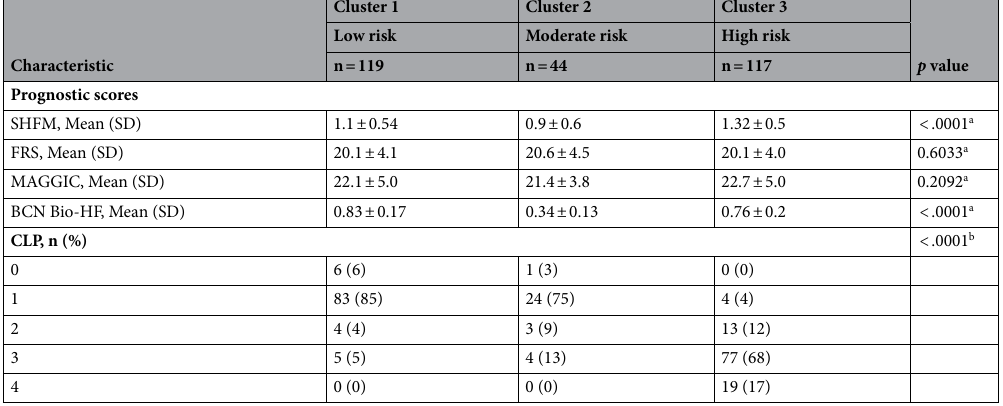
Table 3. Comparison of cohort characteristics and prognostic scores. Cohort characteristics and prognostic score distribution across risk clusters. The prognostic scores used for clustering were: SHFM (Seattle Heart Failure Model), FRS (Framingham Risk Score), and MAGGIC (Meta-analysis Global Group in Chronic Heart Failure), BCN Bio-HF (Barcelona Bio-Heart Failure Risk Calculator), and Cardiac Lipid Panel Risk Score (CLP). Each prognostic score was standardized to the same scale (mean = 0; SD = 1). Ward’s minimum variance method was used for clustering. ACE, angiotensin-converting enzyme; ARB, angiotensin receptor blocker; TAG, triacylglycerol 18:1/18:0/18:0; COPD, chronic obstructive pulmonary disease; E/A, ratio of the early (E) to late (A) ventricular filling velocities; E/e’, ratio between early mitral inflow velocity and mitral annular early diastolic velocity; LAes, left atrial end systole; LDL, low-density lipoprotein; NYHA, New York Heart Association; HDL, high-density lipoprotein; LVDed, left ventricular diameter end diastole; LVDes, left ventricular diameter end systole; LVVed, left ventricular volume end diastole; LVEF, left ventricular ejection fraction; LVVes, left ventricular volume end systole; mg/kg, milligrams per kilograms; NTpro-BNP, N-terminal pro–B-type natriuretic; PC, phosphatidylcholine; SM, sphingomyelin. a Wilcoxon rank sum test, b Pearson’s chi-square test, c Mantel-Haenszel chi-square. * Imputed using the median, 31%, of the normal range 20–40%. † Median (Interquartile